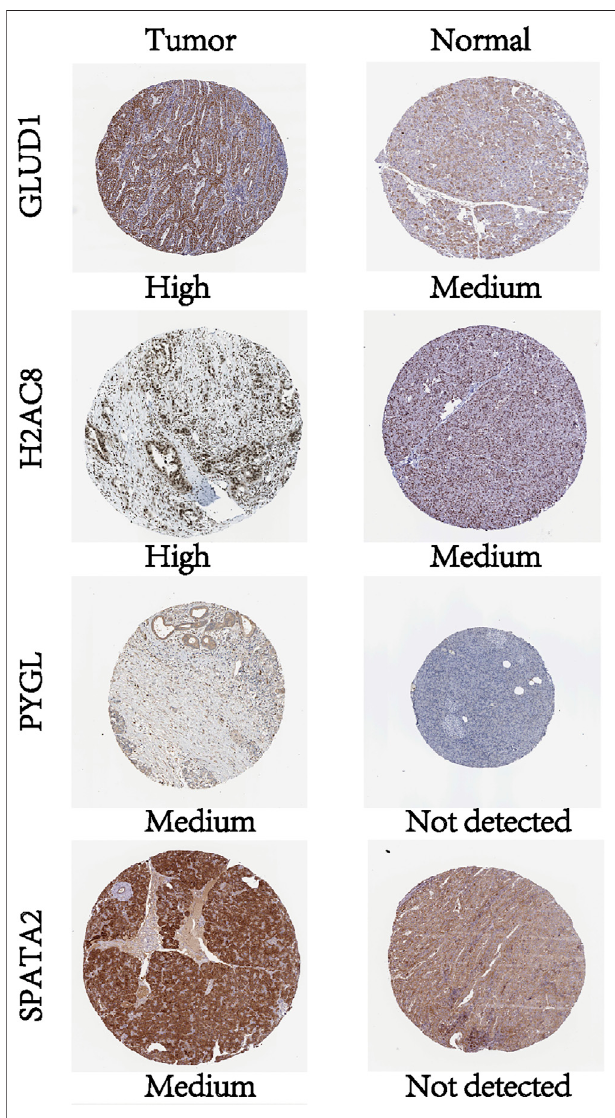
FIGURE 7 | Pro fi les of protein expression of the four NRGs in PCa and normal tissues based on immunohistochemistry results from the Human Protein